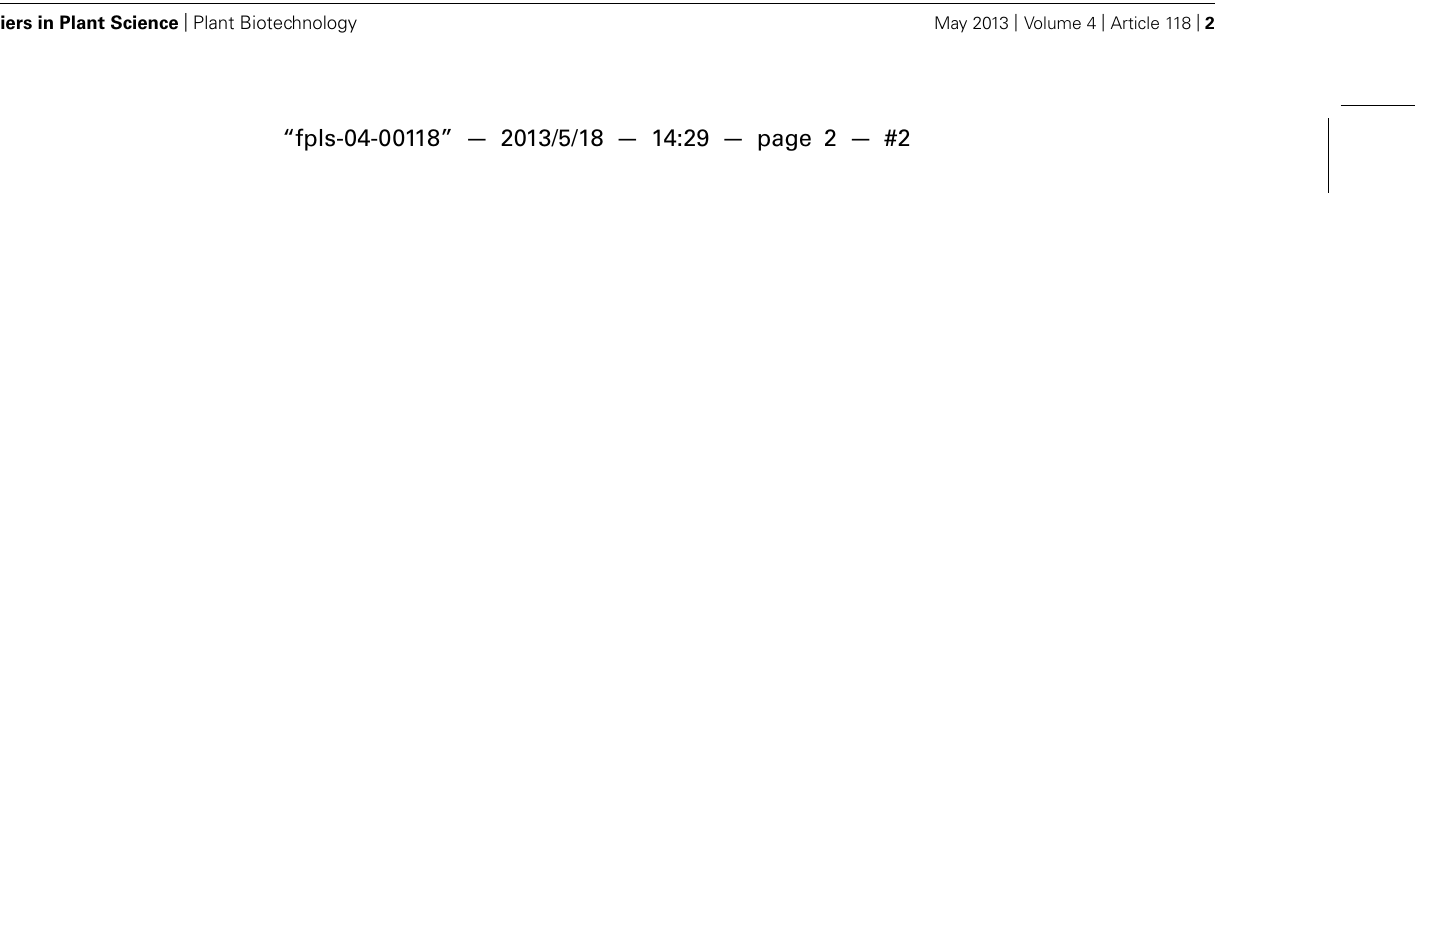
FIGURE 1 | O -acetylation of cell wall polysaccharides. (A) Generic representation of O -acetyl group as found at different -OH positions in many cell wall polysaccharides. Note the structural similarity between O-acetyl- and methyl ester-groups that decorate carboxylic acid residues in polygalacturonic